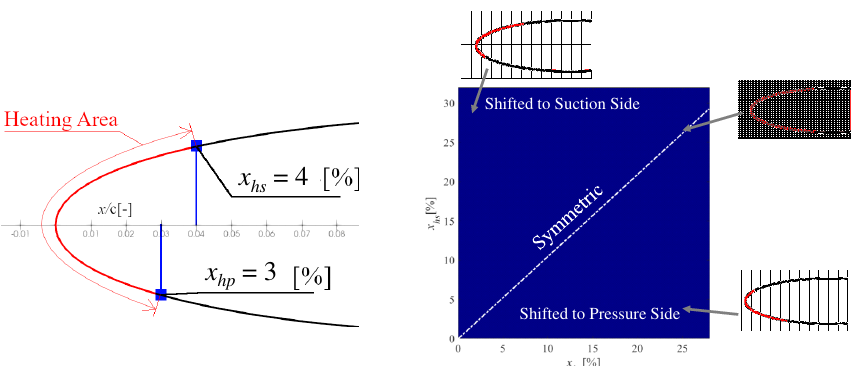
Figure 5. Left, heating area around the leading edge surface location; right, explanation of results map (red lines in the small figures are the heating